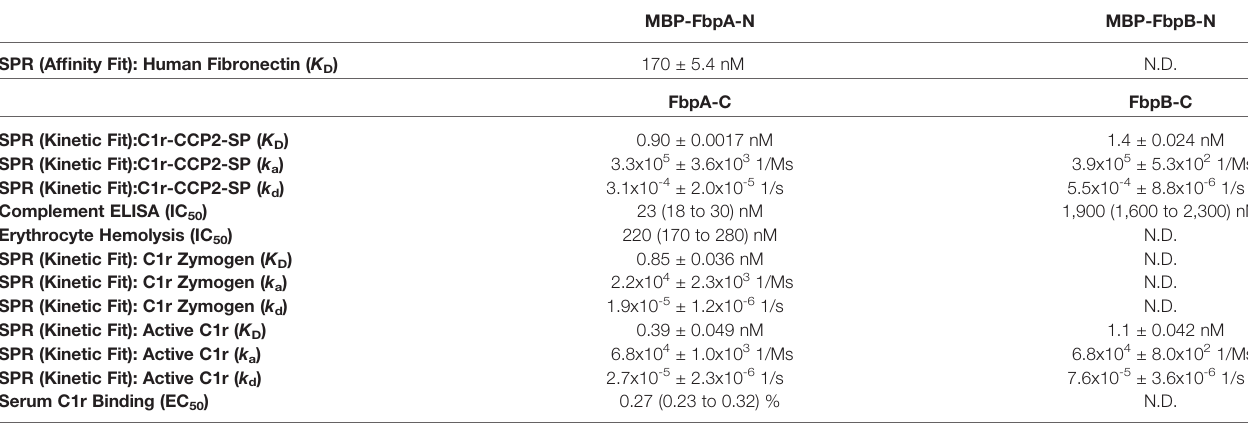
TABLE 4 | SPR and complement assay